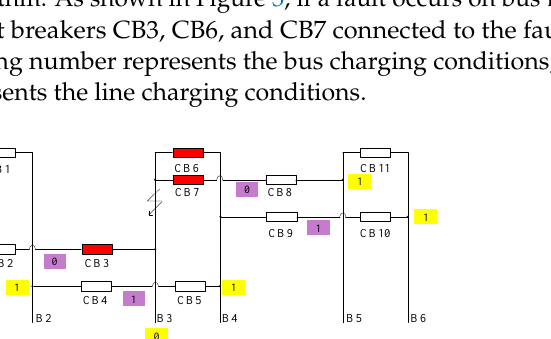
Figure 2. Flow chart of the fault area formation algorithm.